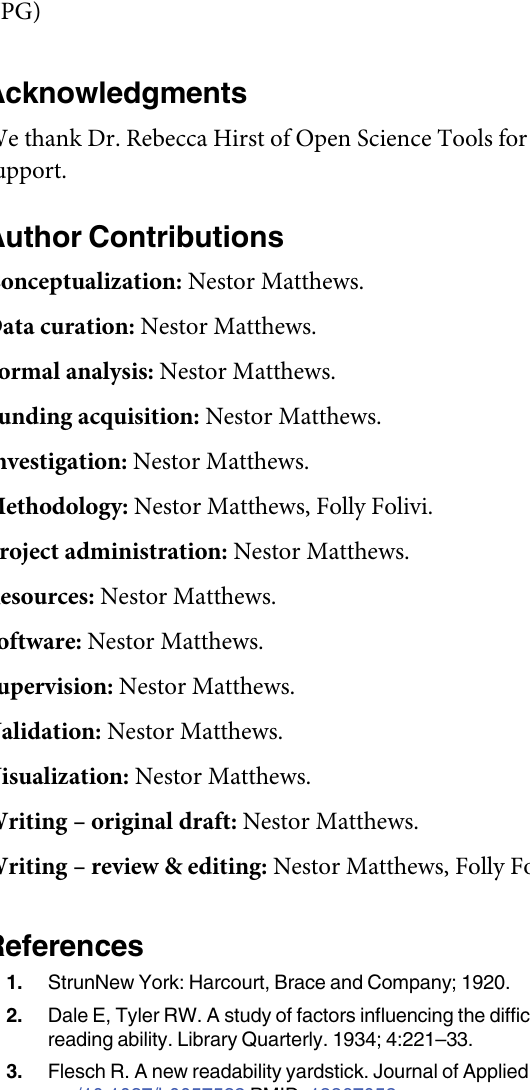
S1 Fig. Standard two-line 17-word sentence. (JPG) S2 Fig. Mirror-reversed two-line 17-word sentence. (JPG) S3 Fig. Upside-down two-line 17-word sentence. (JPG) S4 Fig. Standard three-line 16-word mischievous sentence. (JPG) S5 Fig. Mirror-reversed three-line 16-word mischievous sentence. (JPG) S6 Fig. Upside-down three-line 16-word mischievous sentence.